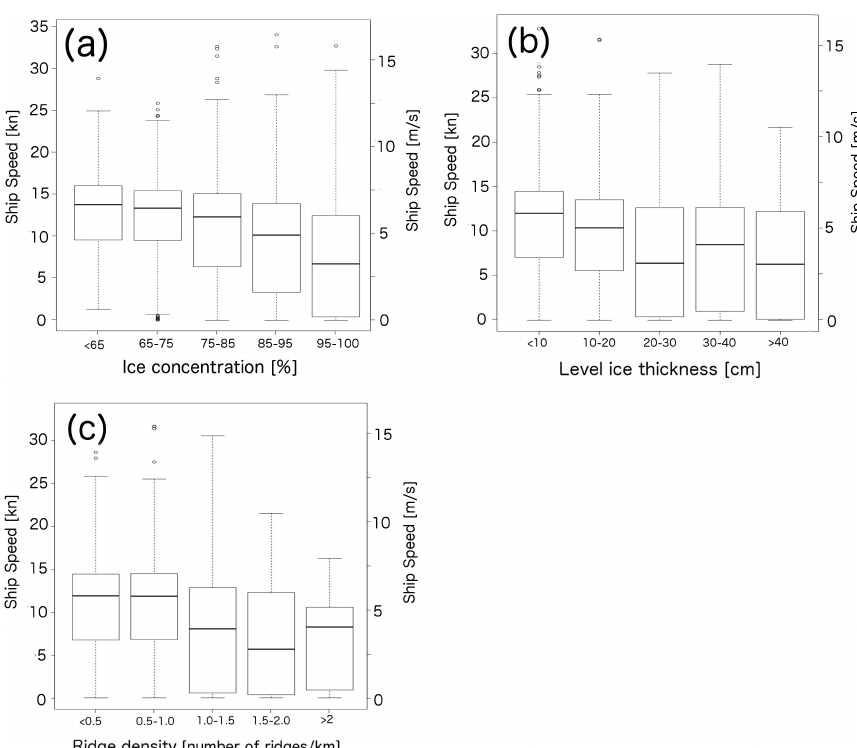
Figure 5. (a) – (c) Observed ship speed distribution under several (binned) ice conditions, described by box plots. The bottom and top of the boxes are the first and third quartiles, while the thicker band inside the boxes depicts the median. Lines extending vertically from the boxes (whiskers) depict ship speeds within 1.5 times the interquartile range of the box. Outliers are plotted as individual points. (a) refers to ice concentration, (b) to ice thickness and (c) to ridge